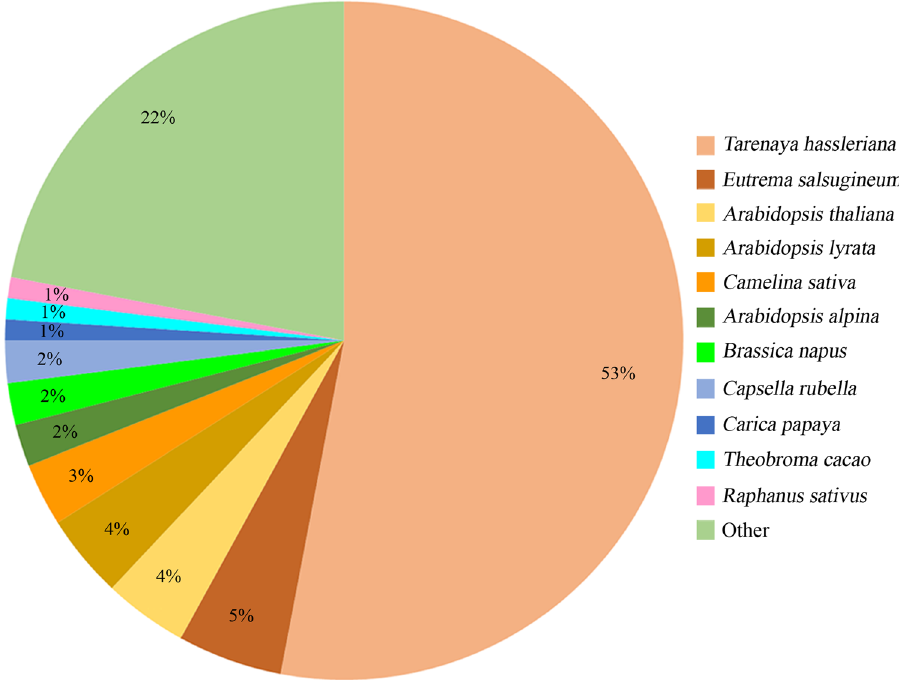
Figure 1. Species-based distribution of blastx matches for each clustered unitranscript of Capparis spinosa leaf transcriptome. The species with a match < 1% were grouped in the ‘Other’ category.